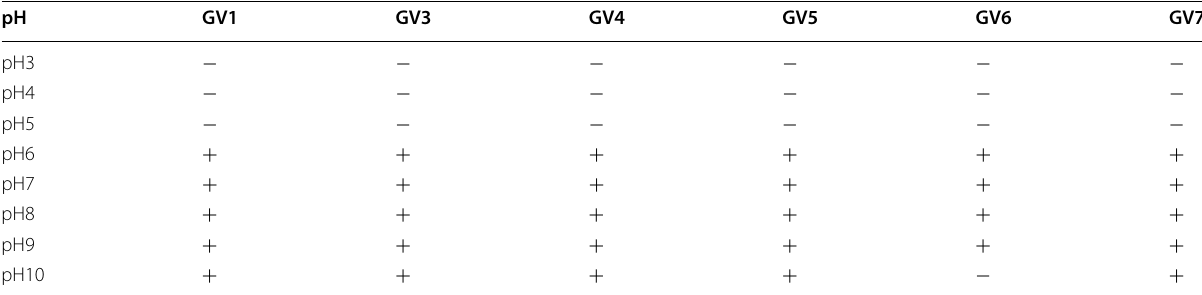
Table 2 Optimum pH range of bacteria pH